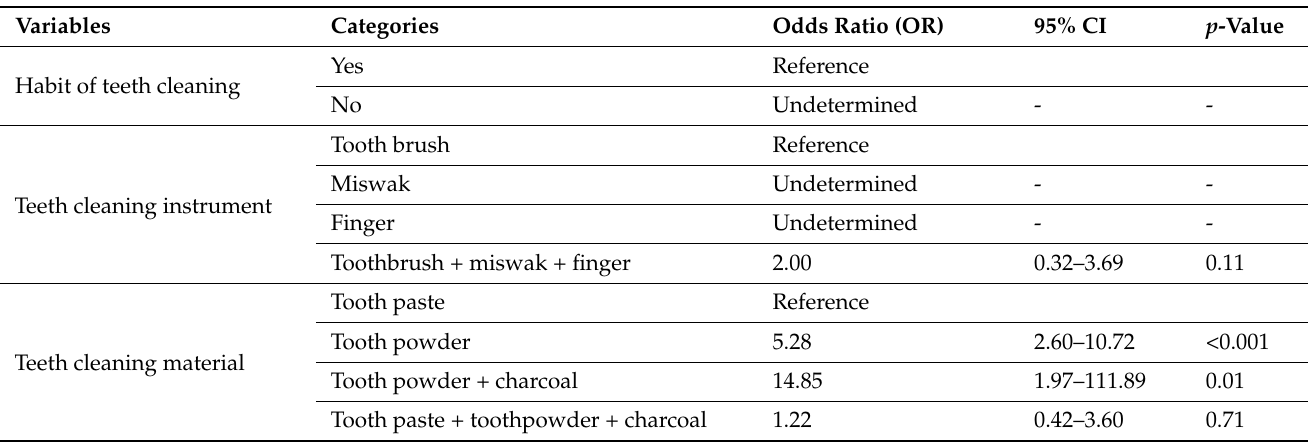
Table 5. Dietary and oral hygiene practices * associated with the occurrence of dental caries in pediatric